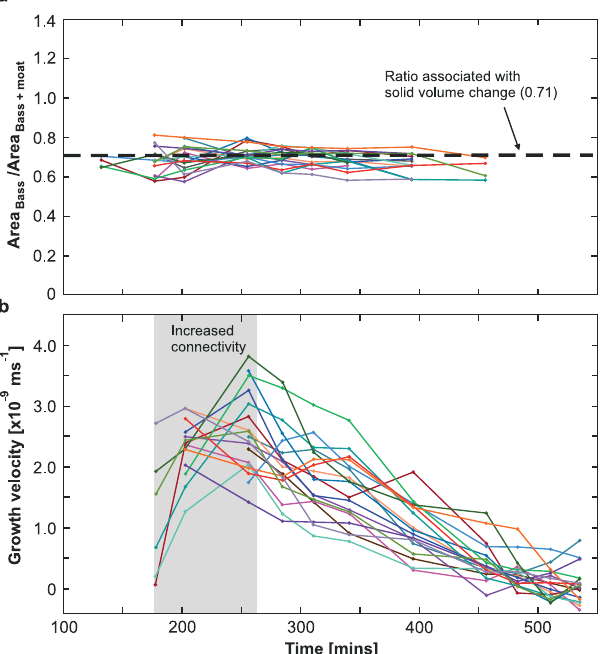
Figure 4. Quantification of the grain areas and growth velocities with time. ( a ) Ratio of the areas between the grain and the grain + moat. Different curves represent individual grains and their associated moats. Values oscillate around a central ratio of 0.71 which is equivalent to the solid volume change associated with the reaction (i.e. molar volume of bassanite/molar volume of gypsum = 0.71). Once the moats begin to coalesce they can no longer be associated to a given grain and therefore the ratio can no longer be analysed, hence why the curves do not continue for the duration of the experiment. ( b ) Grain growth velocity curves for individual bassanite grains. The grey shaded area represents the time when the connectivity of the sample dramatically increases. This corresponds to an initial acceleration in growth velocity for the majority of grains. Once the drainage architecture has established itself the growth velocities decrease with time, which is associated with diffusion of solutes across the moats (Fig.